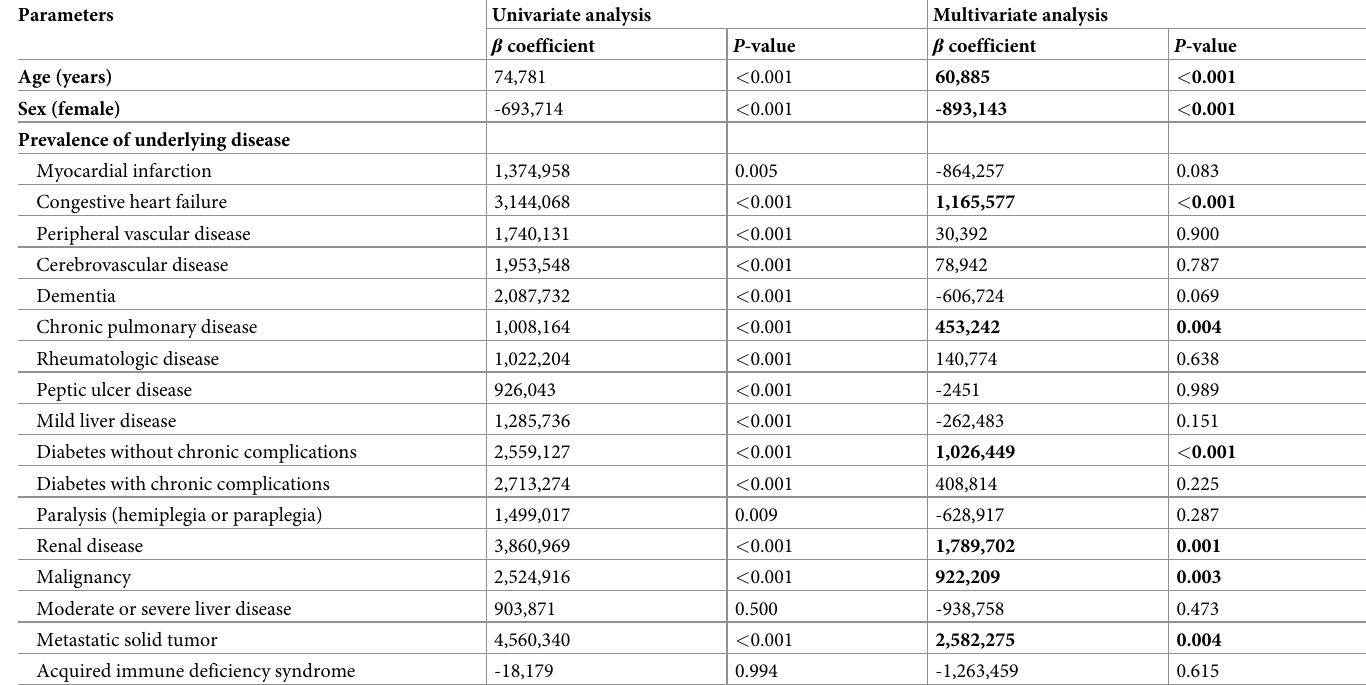
Table 5. Significant factors for the total hospital